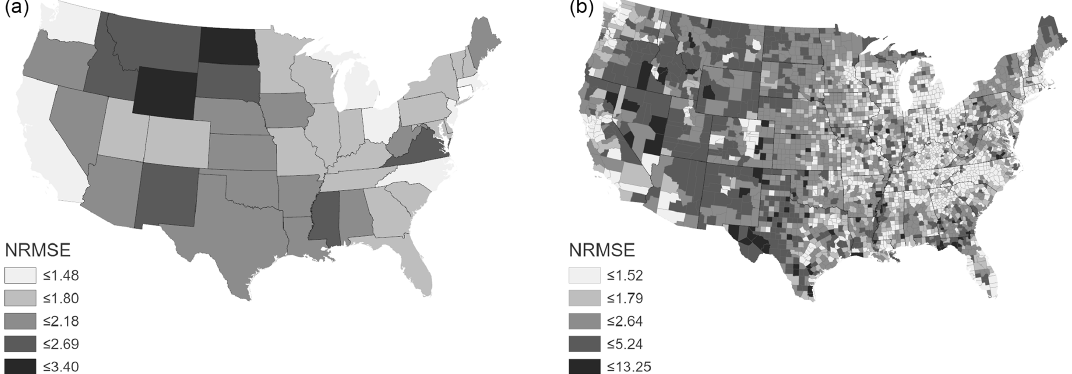
Figure 4. NRMSE between block population estimates and block population census counts calculated for CONUS states (a) and counties (b) . Block population was estimated by running IDM with census tracts as source units and applying representative population densities estimated by IDM using census blocks as preset